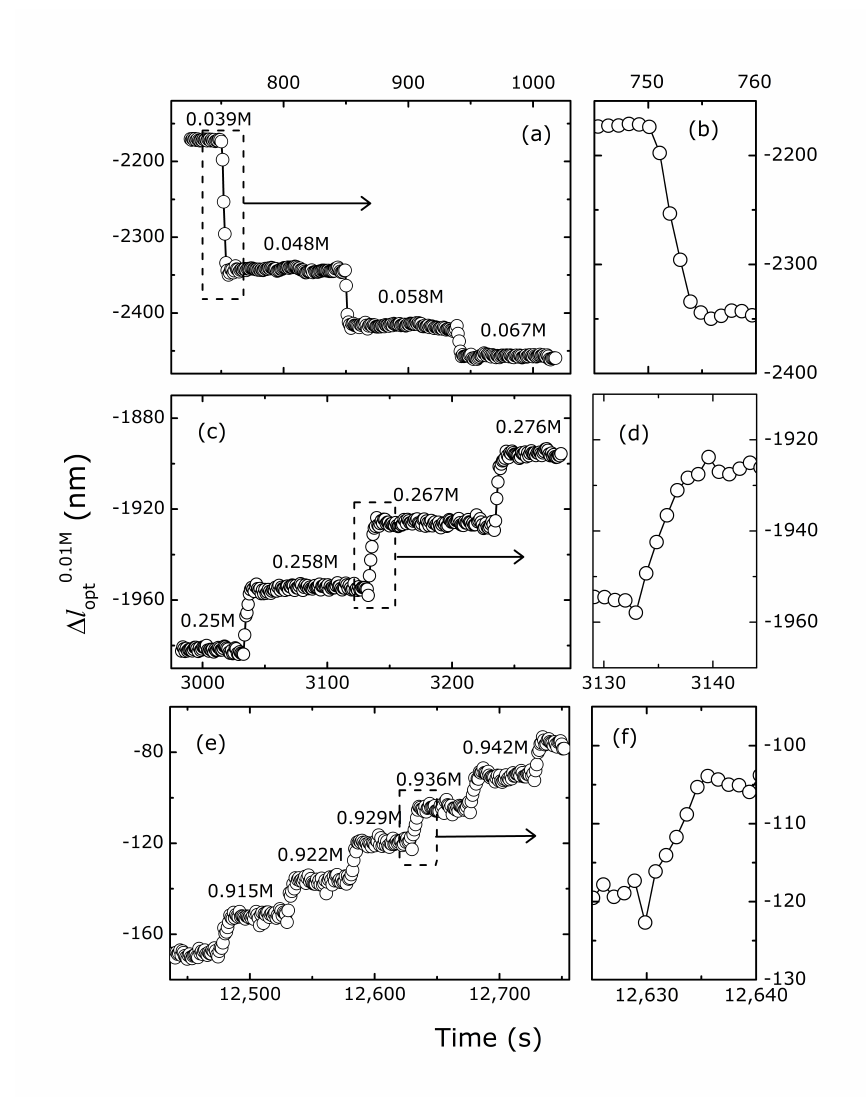
Figure 2. Change in optical length of the weakly charged cationic (AAm- co -ATMA, 3 mol%) hydrogel versus time for step-wise increase in ionic strength using aliquotes of 2 M NaBr for three different regions of characteristic behavior of swelling. ( a ) Transient swelling in the region of [NaBr] where the Donnan mechanism is dominant. ( c ) Transient swelling data for gel swelling as a result of additive influence of the Donnan mechanism and specific ion effect. ( e ) Transient swelling data at larger NaBr concentration where the gel swelling are due to the specific ion effect of the added salt. The averaged plateau values just before successive adding of the NaBr solution are used as basis for calculating the equilibrium swelling data. The graphs in the right column ( b , d , f ) depict examples of the change in the optical length at higher time resolution for one selected step change in salt concentration within each region shown in the square of the main